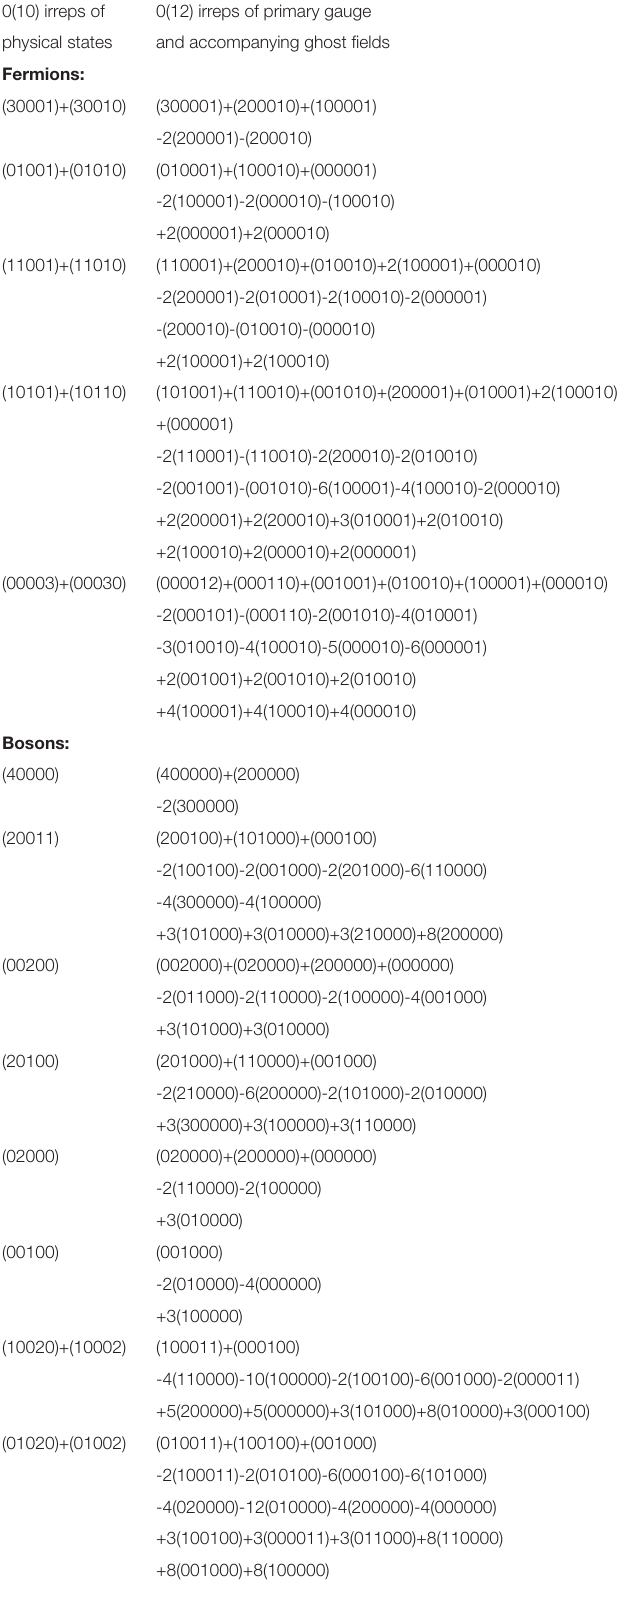
TABLE 3 | Gauge field and ghost arrays. 0(10) irreps of 0(12) irreps of primary gauge physical states and accompanying ghost